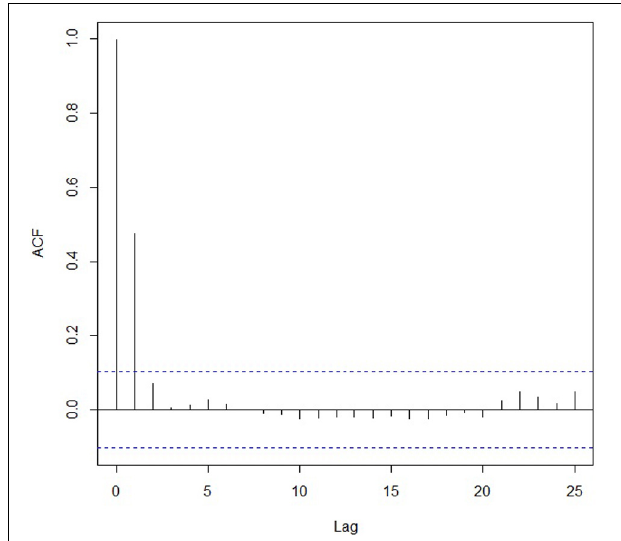
FIGURE 2 | Autocorrelation function (ACF) for one iteration of Experiment